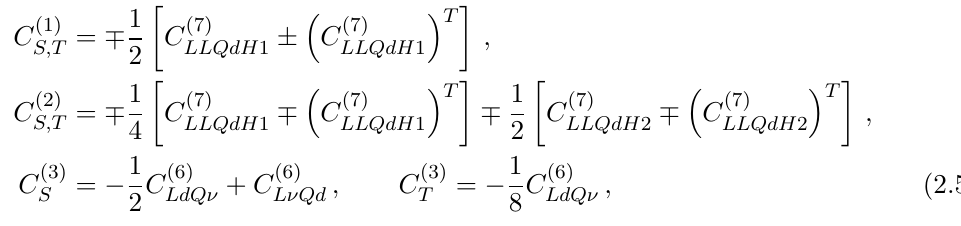
where C = ( N 2 (cid:0) 1) = (2 N ) for N = 3, the number of colors. In addition, there are c c F c